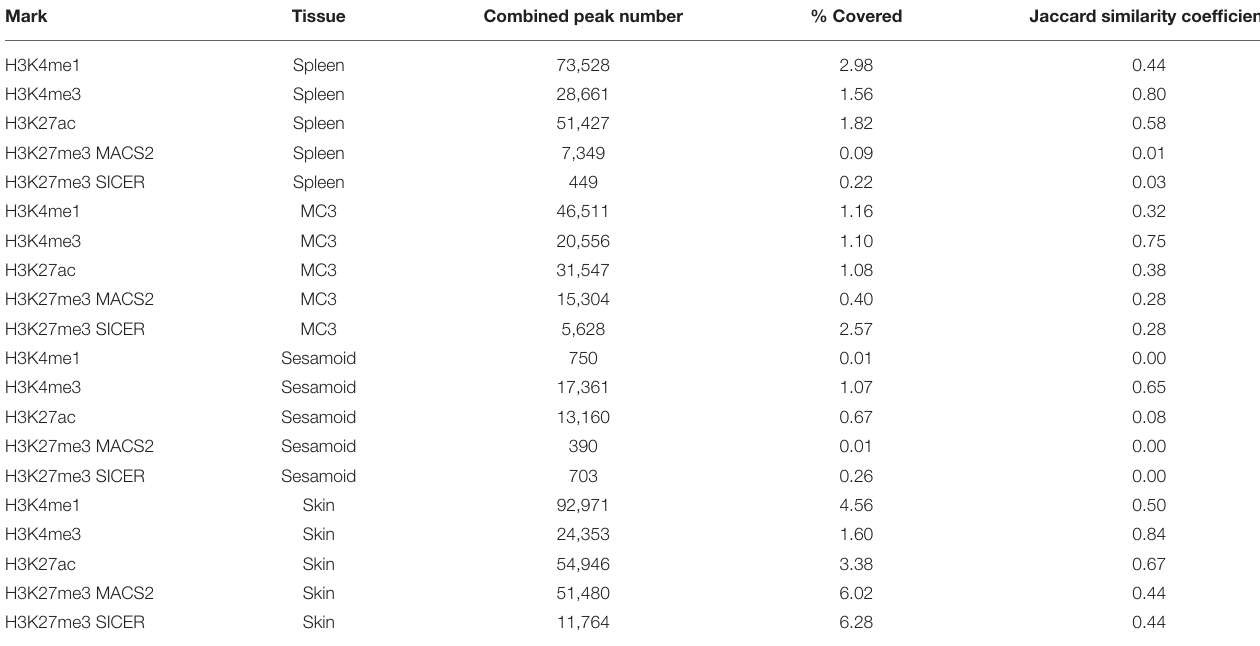
TABLE 2 | Summary of the combined peak calls and replicate comparison.